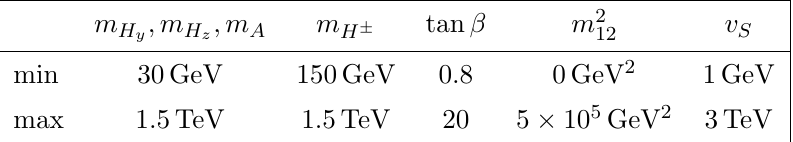
Table 2 . Input parameter ranges for the N2HDM parameter scan ( y; z 2 f 1 ; 2 ; 3 g ). The three mixing angles (cid:11) 1 ; 2 ; 3 in the CP-even scalar sector are scanned through their whole allowed